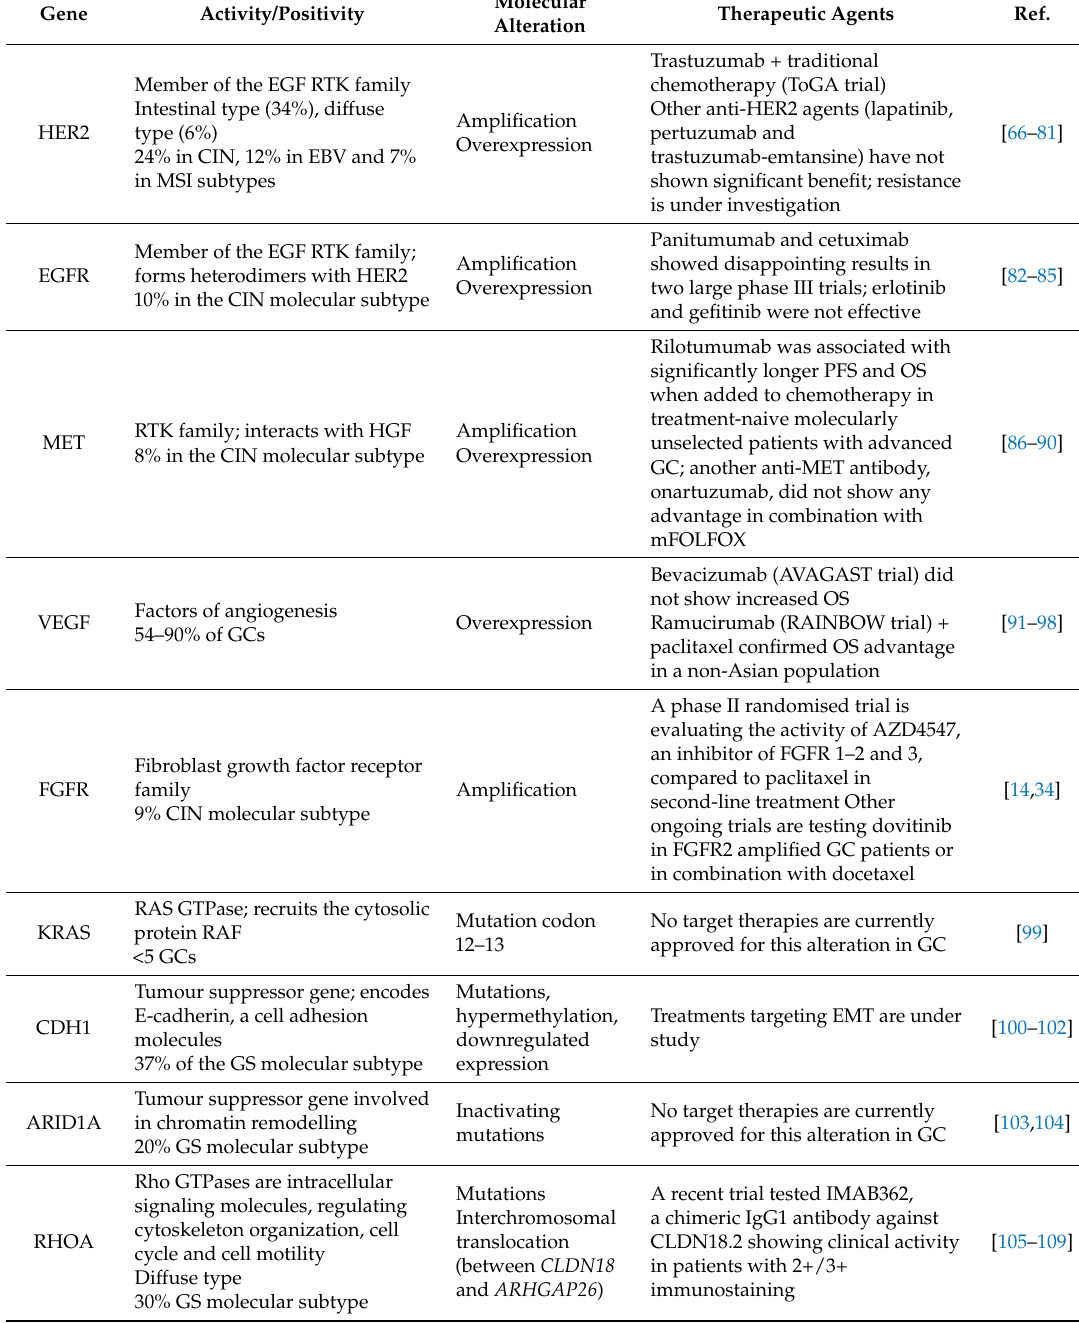
Table 2. Gene alteration and their respective targeted